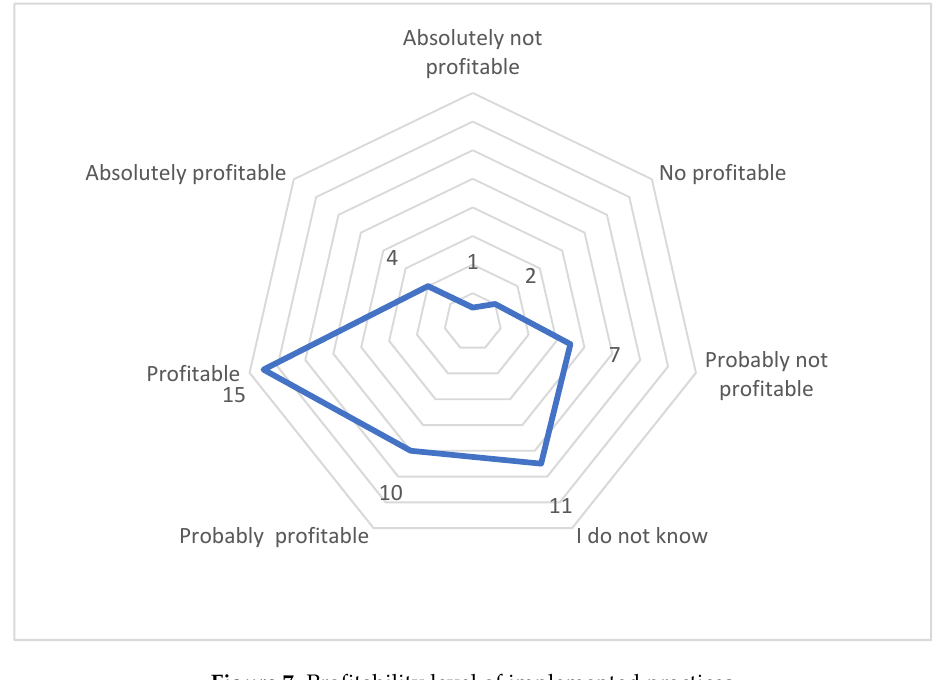
Figure 7. Profitability level of implemented practices.